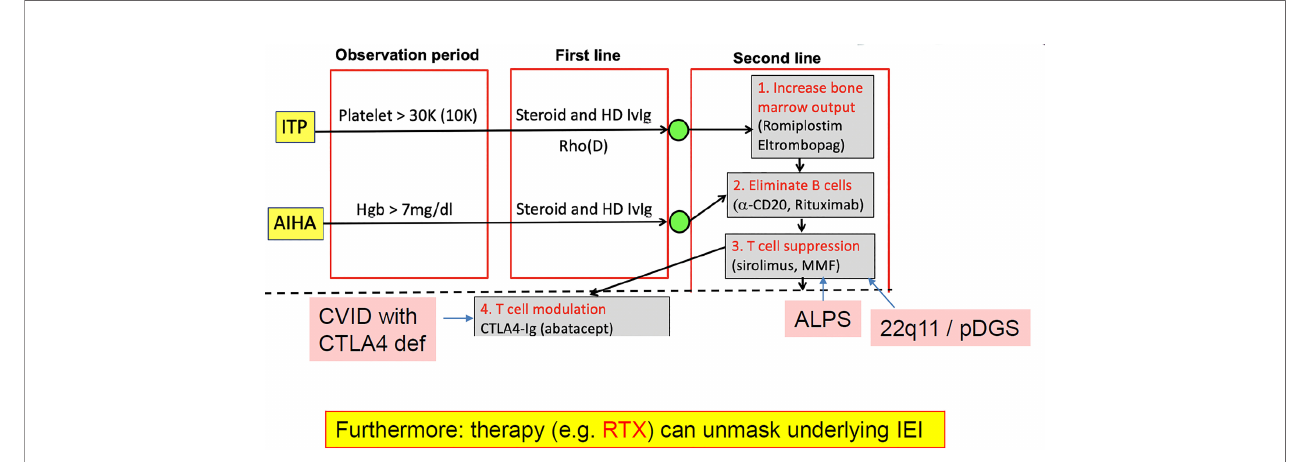
FIGURE 3 | Underlying primary immunode fi ciency (PID) in autoimmune cytopenia: early diagnosis can alter the treatment pathway. AIHA, autoimmune hemolytic anemia; ALPS, autoimmune lymphoproliferative syndrome; CVID, common variable immune de fi ciency; HD, high dose; Hgb, hemoglobin; IEI, inborn error of metabolism (=primary immunode fi ciency); ITP, immune thrombocytopenia; IVIg, intravenous immunoglobulin; RTX,